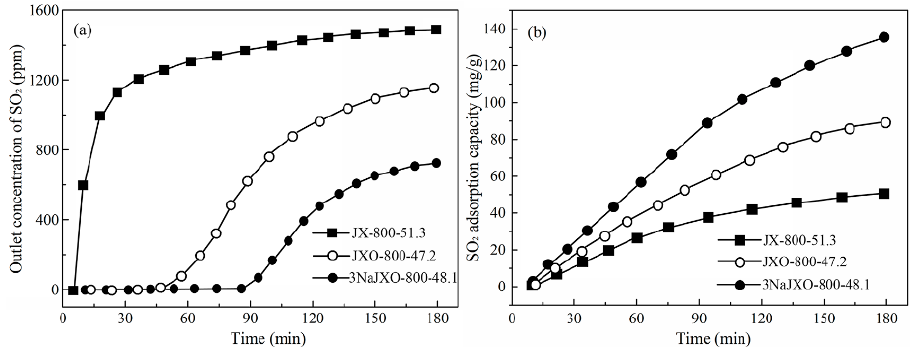
Figure 6. SO 2 removal of typical activated carbon ( a ) SO 2 breakthrough curve; ( b ) SO 2 adsorption quantity.